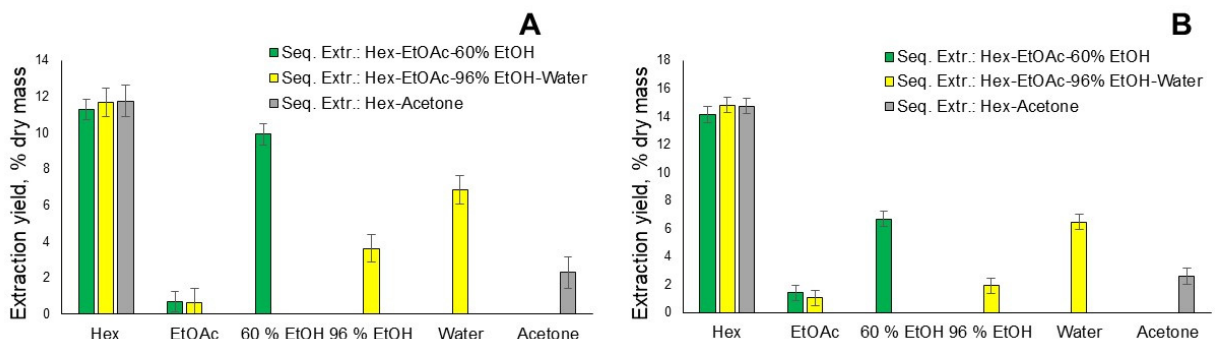
Figure 3. ( A ) Total extraction yield % of CK spent coffee ground sequential extraction with organic solvents, depending on extraction scheme and used solvent. ( B ) Total extraction yield % of CO spent coffee ground sequential extraction with organic solvents, depending on extraction scheme and used solvent ( n = 3, error bars indicate SD).